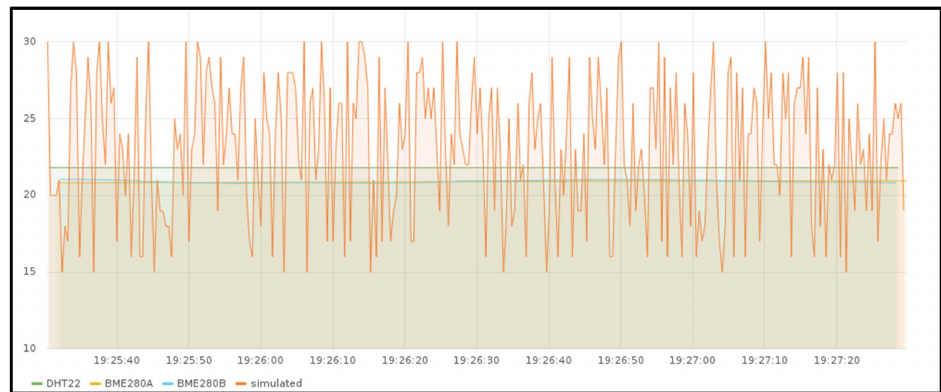
Figure 6. Temperature generated by BME280 and DHT22 sensors together with emulated background tra ffi c measured at the IoT gateway deployed in Raspberry Pi Kubernetes